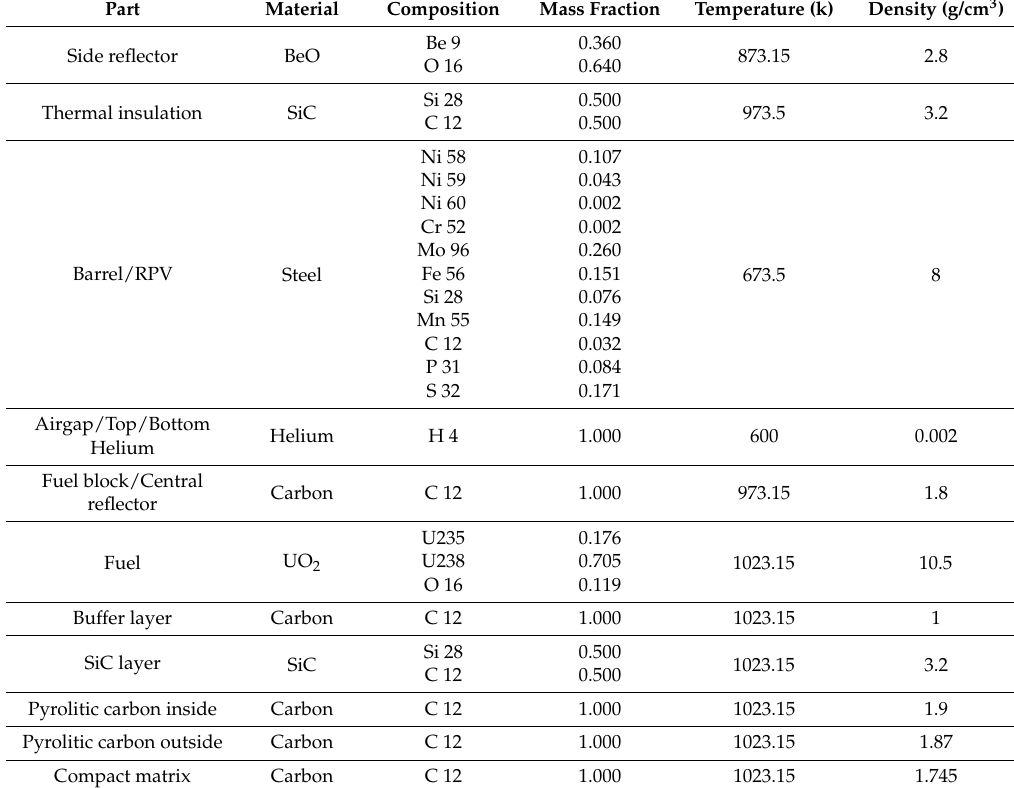
Table A3. Material